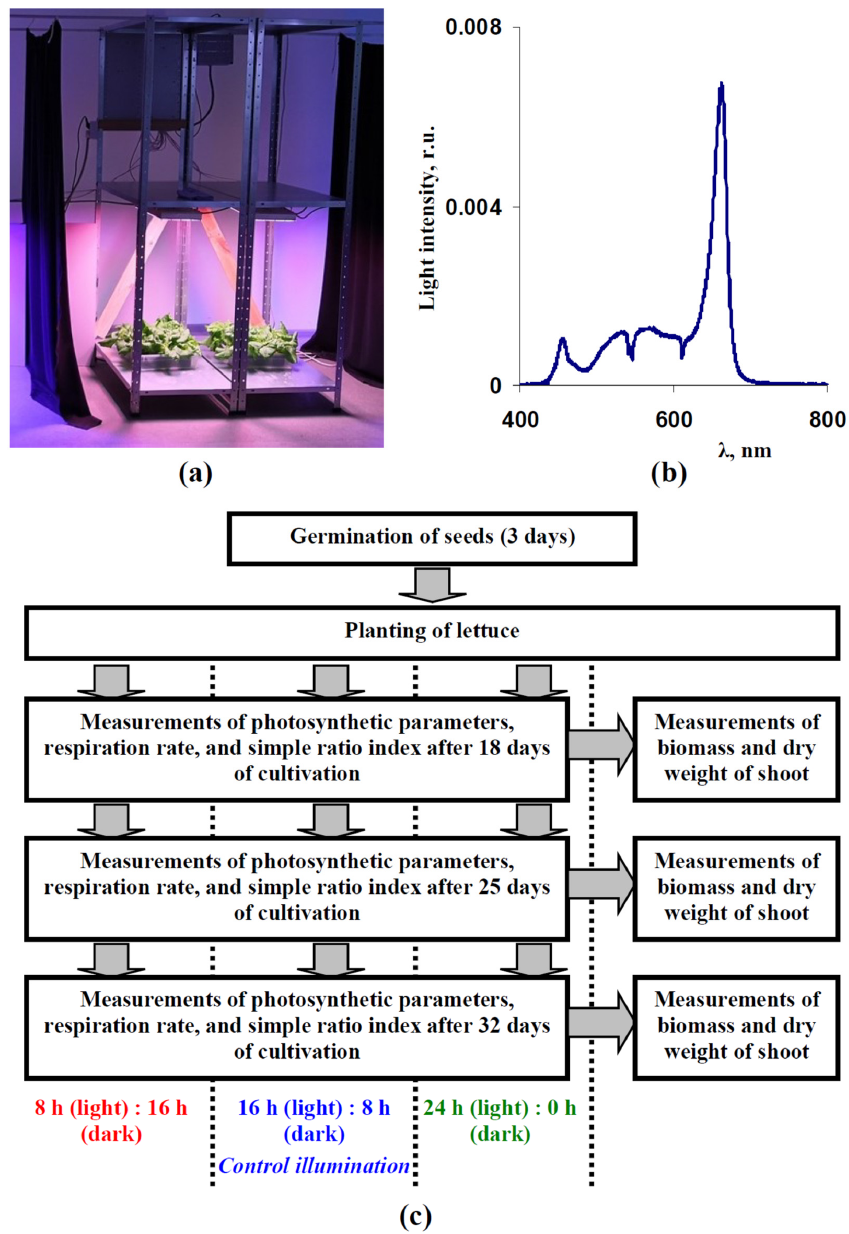
Figure 11. ( a ) Equipment used for lettuce cultivation under controlled light spectrum, intensity and photoperiod. ( b ) The illumination spectrum which was used for the lettuce cultivation. The spectrum was normalized on the total sum of intensities within 400–800 nm. The total light intensity was about 180 µmol m − 2 s − 1 . ( c ) General scheme of the lettuce cultivation and measurements of photosynthetic parameters, dark respiration rate, relative chlorophyll content, biomass, and dry weight (see Section 4 for details). Measurements of green area per plant, which were periodically performed after 10 days of the cultivation, were not shown in the scheme.